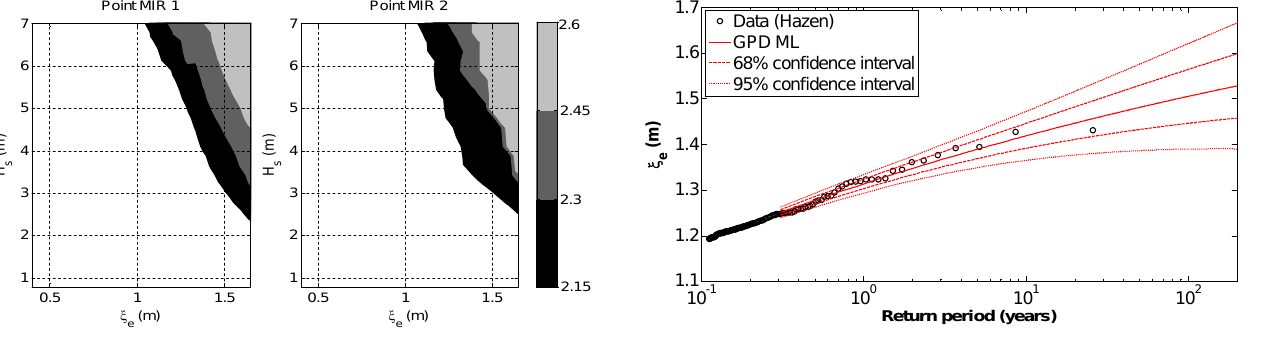
Fig. 6. Total water level ξ ec (m) at the beach versus offshore water level ξ e and offshore significant wave height H S .